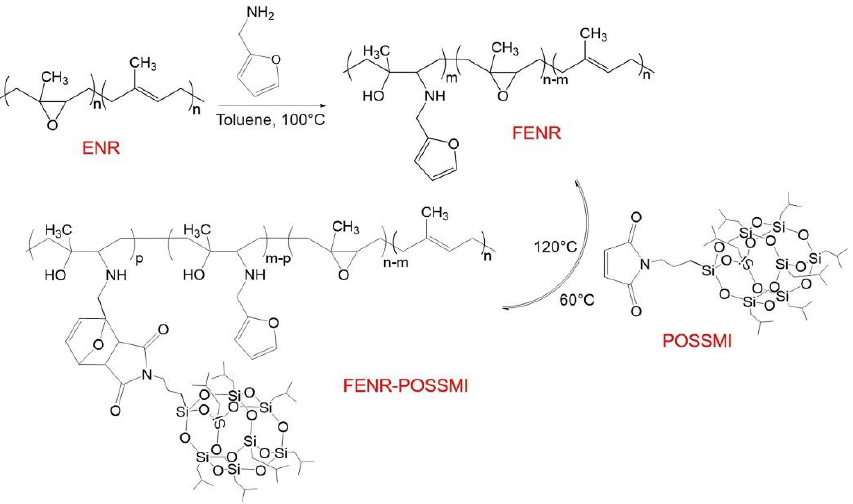
Figure 17. Synthesis of furfuryl modified ENR (FENR) and its thermoreversible DA ‘click’ post-modification with POSSMI. Reprinted from Eur. Polym. J. 2021, 146 , Raut, S.K.; Mondal, P.; Parameswaran, B.; Sarkar, S.; Dey, P.; Gilbert, R.; Bhadra, S.; Naskar, K.; Nair, S.; Singha, N.K., Self-healable ultrahydrophobic modified bio-based elastomer using Diels-Alder ‘click chemistry’, 110204, [76]. Copyright (2021), with permission from Elsevier.